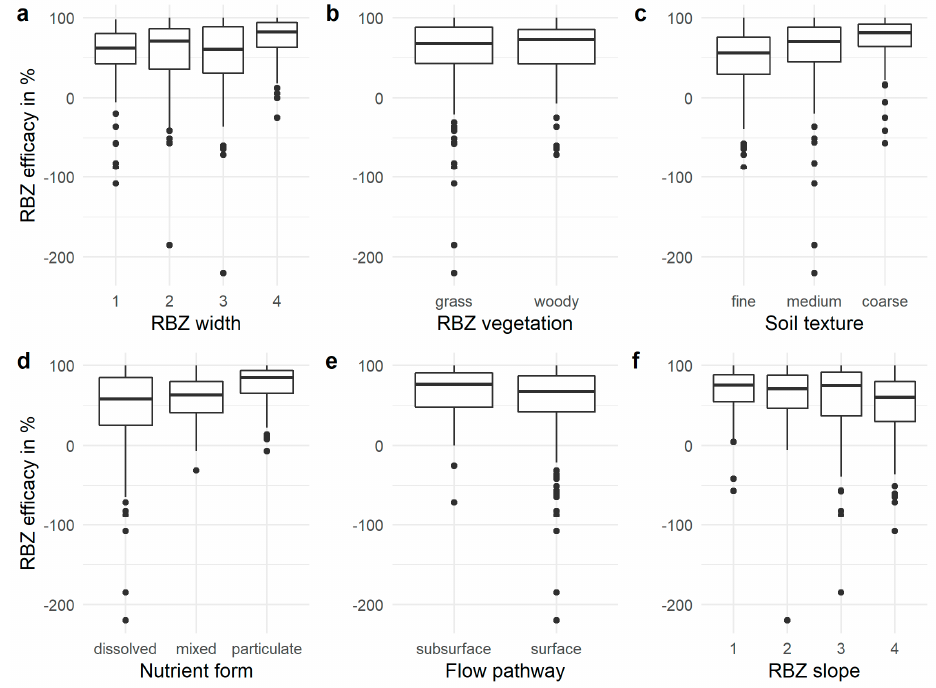
Figure 4. RBZ efficacy for the states of the parent nodes using the maximum number of states as given in Table 1. Higher state numbers correspond to broader RBZ ( a ) and steeper RBZ ( f ).